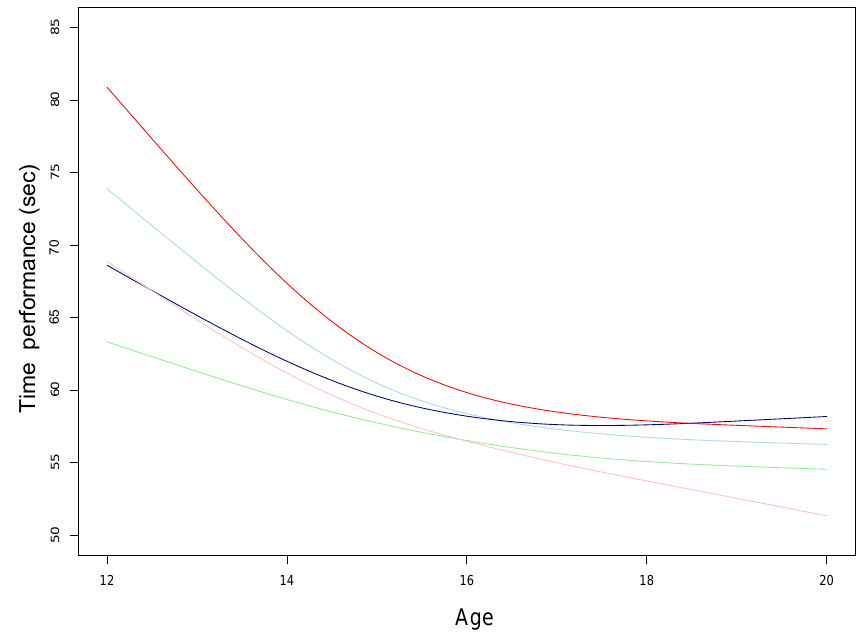
Figure A3. Clusters’ centres of the progressions’ curves. Computed with the univariate funHDDC algorithm. Clusters show different patterns of evolution, and some progression curves cross each others. The same level of performance at 12 years old (e.g., pink and blue curves) can lead to really different levels when older.